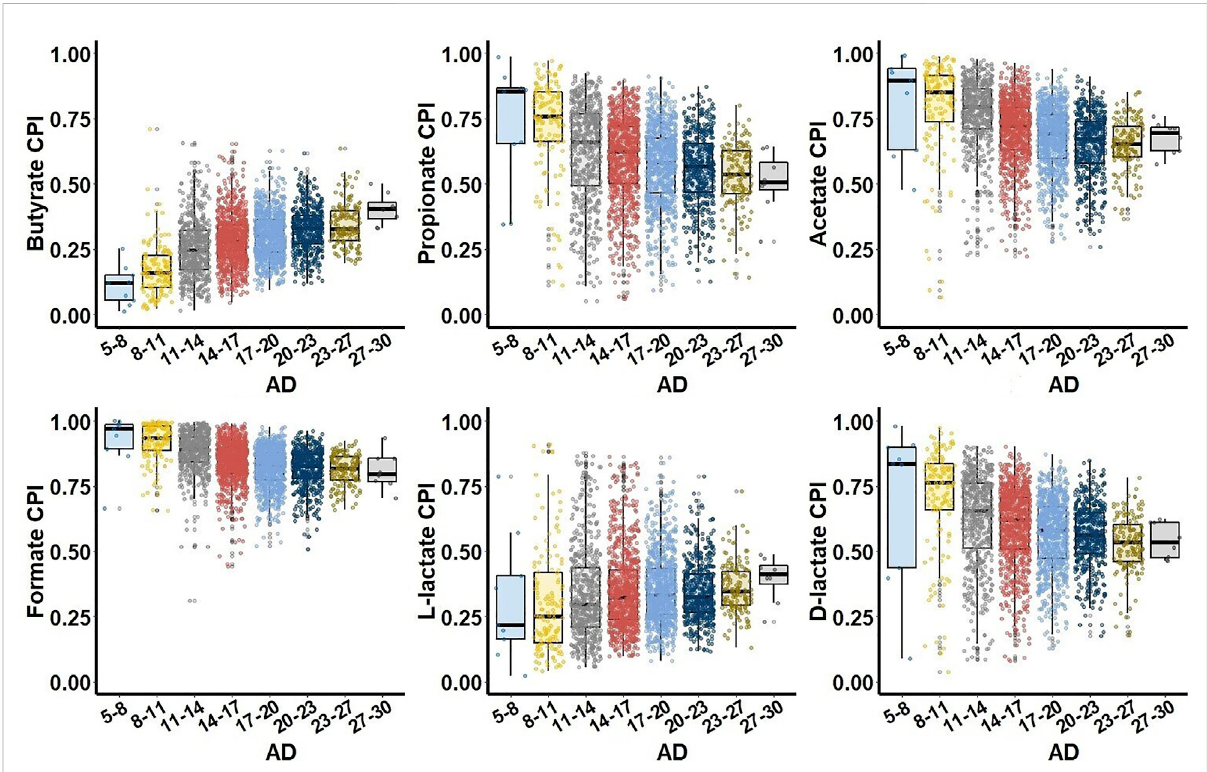
FIGURE 3 Relationship between Community Phenotype Indices (CPI) and Alpha Diversity (AD) for the UKT dataset. Samples are grouped together based on their AD values calculated using Faith phylogenetic diversity